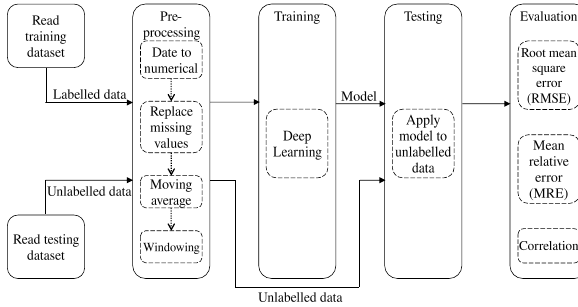
Figure 3. Prediction work-flow for supervised Deep